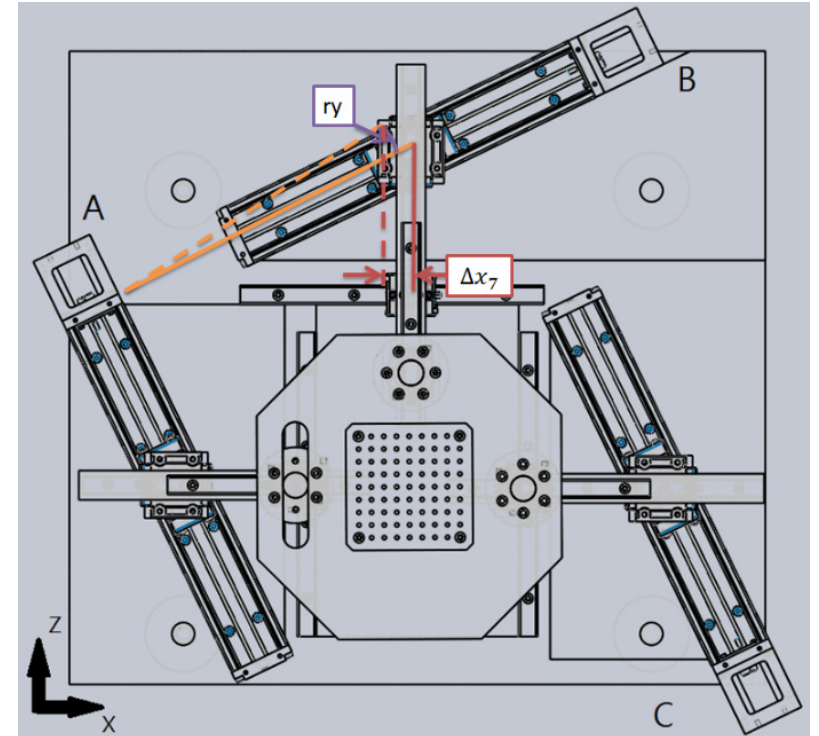
Figure 14. Structure of the ballscrew B rotation error.